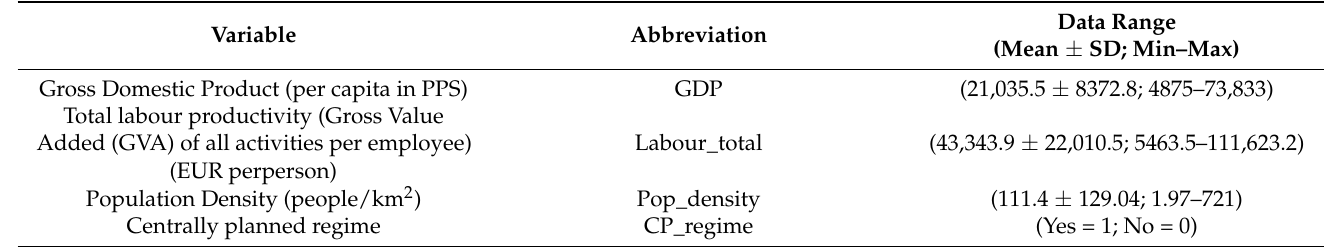
Table 1. Variables included in the correlation analysis.